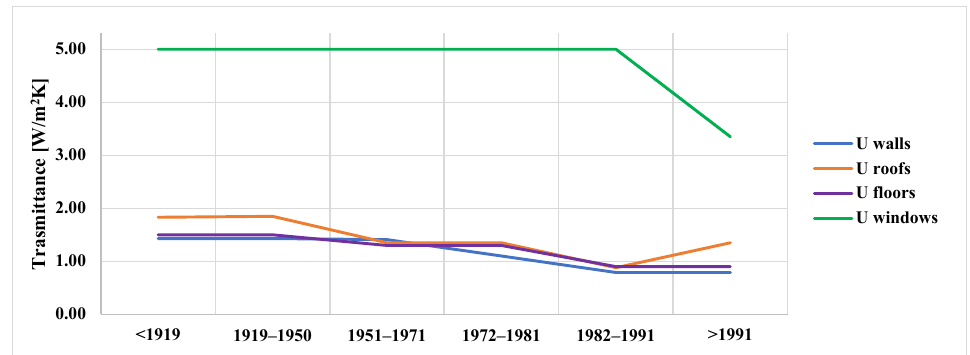
Figure 3. Trend in average thermal transmittance by walls, floors, roofs and windows of the average flat in Salerno, by age of construction (data from [19]).